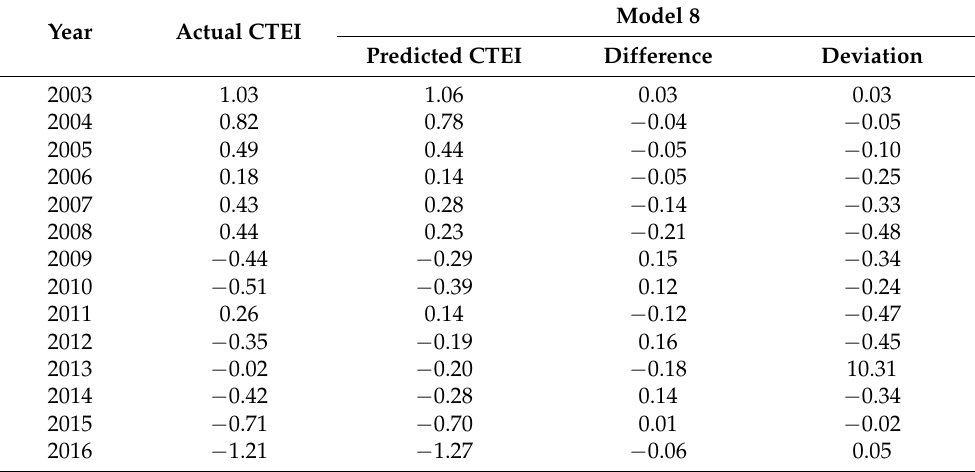
Figure 8. Comparison of all the models with the best machine learning (ML) algorithm (model 8, SVM) for the actual and predicted CTEI values for 2003–2016. Table 3. Average actual and predicted CTEIs and differences and deviations for the best machine learning models in the training and testing periods in the Ganga basin.